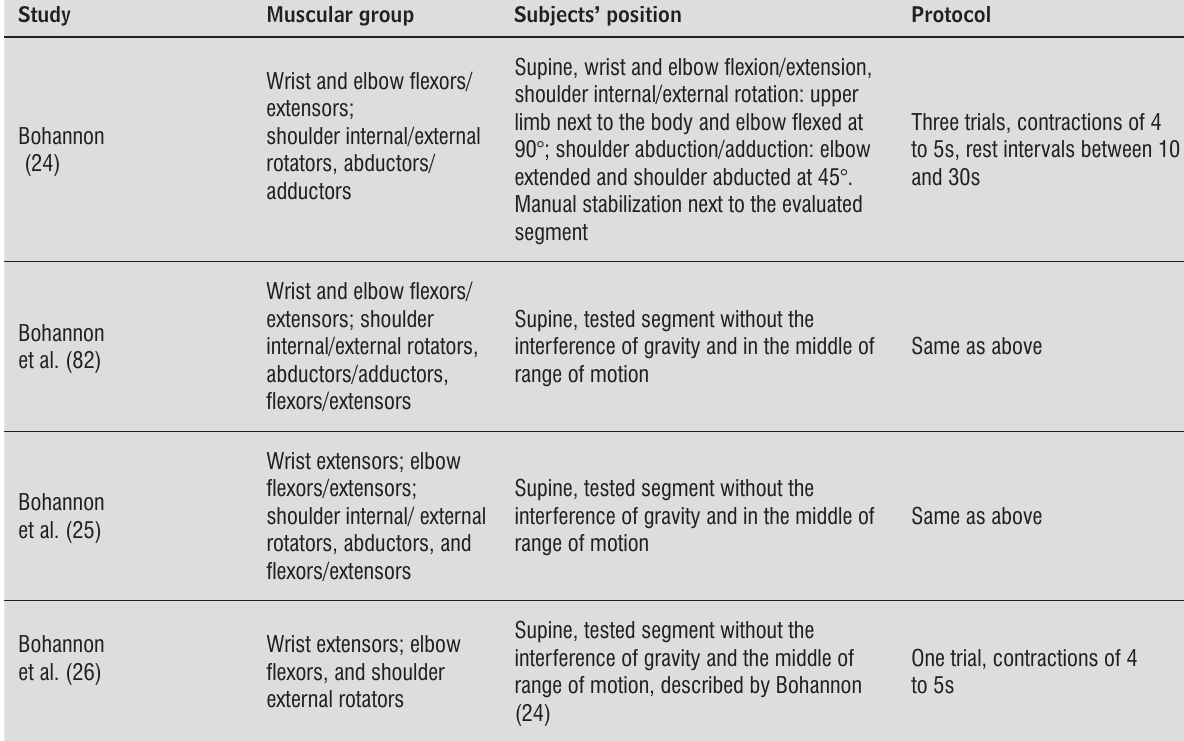
Table 4 - Data extraction of the 14 studies which assessed the upper limb strength in subjects with stroke with portable dynamometers and provided information regarding the subject’s positioning or the data collection